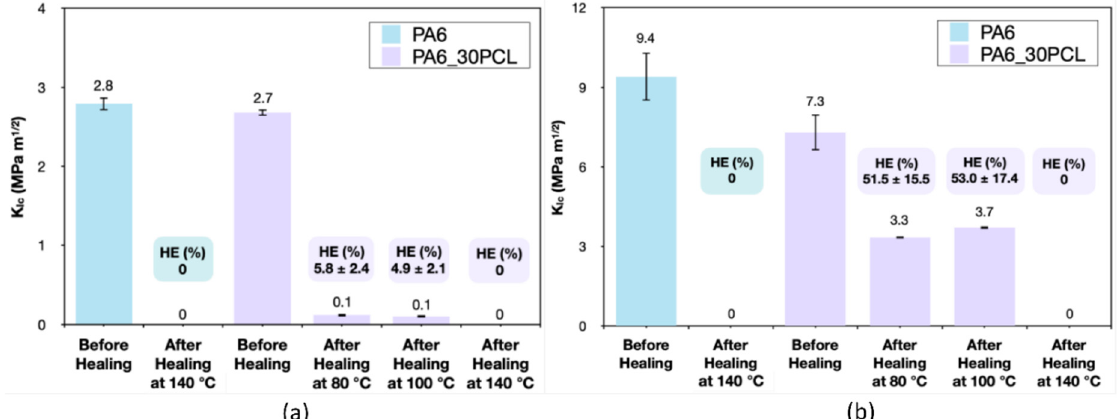
Figure 11. Evaluation of the healing efficiency in quasi-static and impact mode for the PA6_30PCL blend. ( a ) Quasi-static mode, ( b ) impact mode.